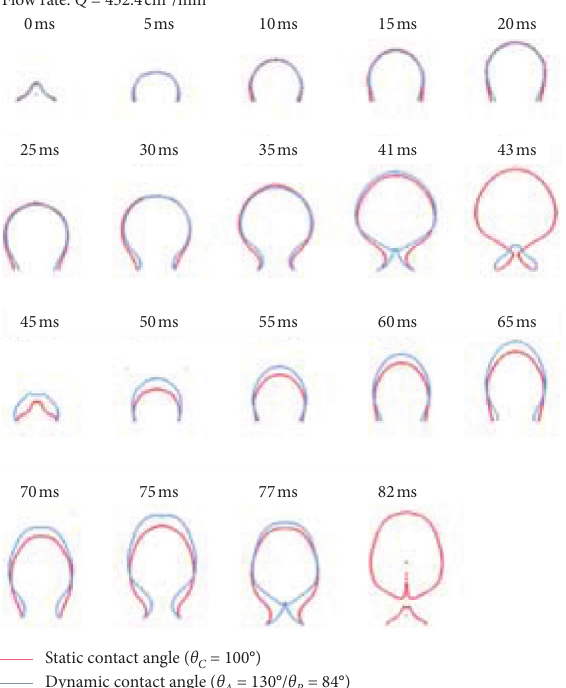
Figure 10: Comparison of profile between dynamic and static contact angle ( Q � 452.4cm 3 /min, Re � 164.30, and d 0–41ms (43ms for the static contact angle model); second bubble: 45–77ms (82ms for the static contact angle model); advancing contact angle period: 0–20ms for the first bubble and 45–65 ms for the second bubble; receding contact angle period: 20–35 ms for the first bubble and 65–75ms for the second